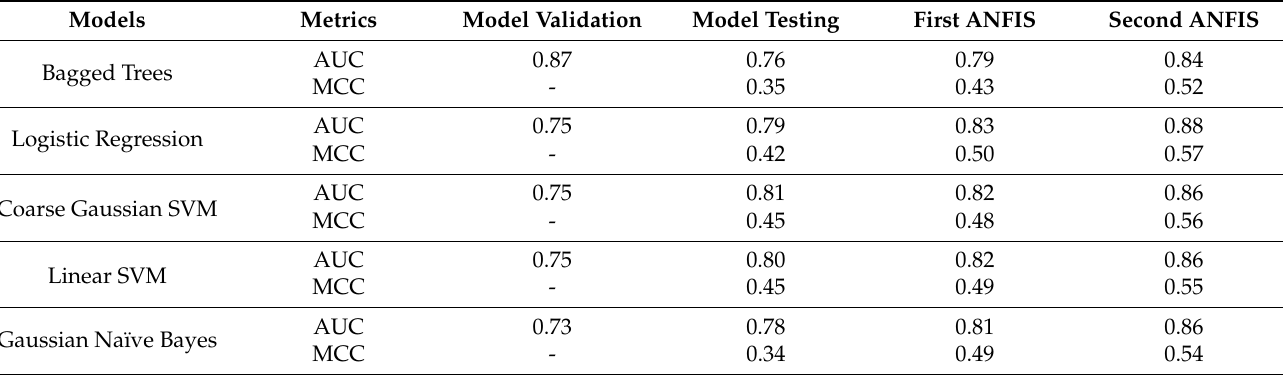
Table 9. Test results for AHI 10.